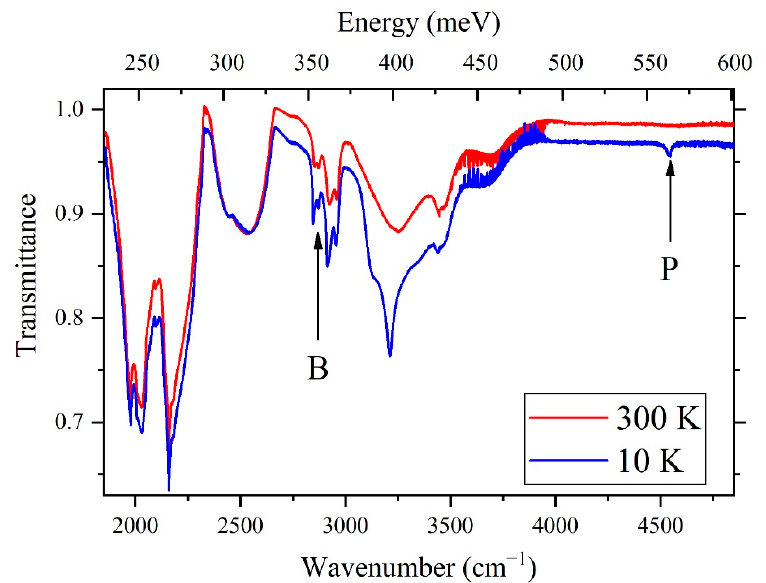
Figure 2. Transmission spectra of diamond sample Ph14N2 in the IR region (1800–4800 cm − 1 ) at 10 (blue) and 300 K (red). The spectra are shifted for convenience.